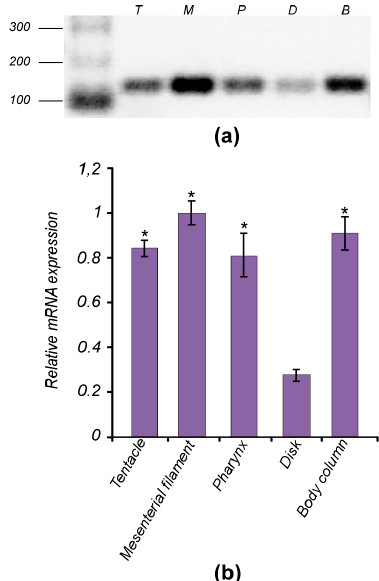
Figure 7. Expression patterns of AvTCTP in various tissues. ( a ) Non-quantitative RT-PCR performed to define the tissue specific expression pattern. Total RNA was extracted from different anatomical districts of the sea anemone: tentacles (T), pharynx (P), mesenterial filaments (M) basal disk (D), body column (B). ( b ) RT-qPCR of AvTCTP mRNA in the same tissues. Transcript levels in tentacles, pharynx, basal disk and body column were normalised to that of mesenterial filaments. RCC2 and COP- γ were used as housekeeping genes. The results are represented as means ± SD ( n = 3). Statistical analysis